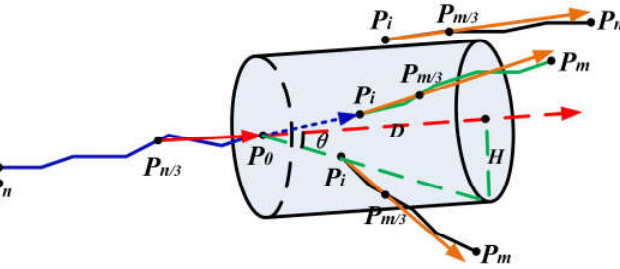
Figure 17. Diagram of connectivity judgments. The blue line is the connected discontinuity trace, the red arrows indicate the connected discontinuity trace, the black line is near the discontinuity trace, the orange arrows indicate locations maintaining a connection to the discontinuity trace, the green line is the best connected discontinuity trace, D is the connection radius, θ is the directional offset and H is the spatial offset.